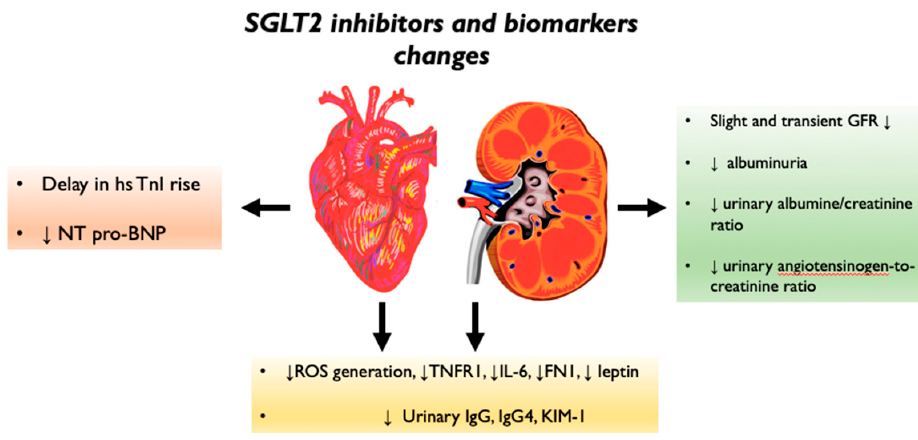
Figure 2. SGLT2 inhibitor and biomarker